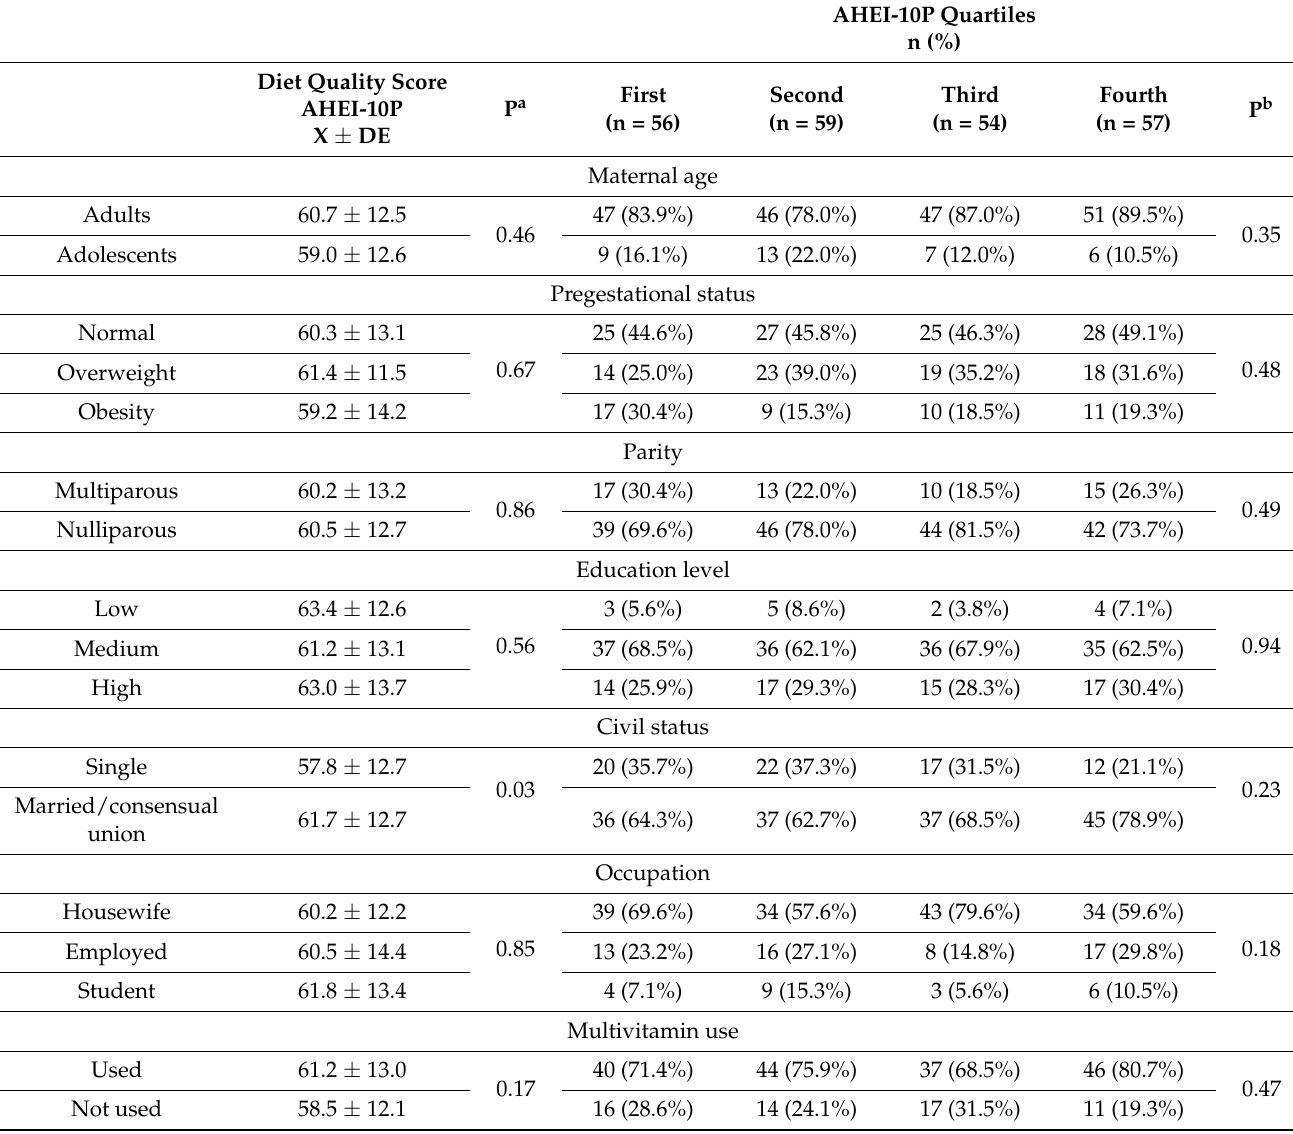
Table 2. Diet quality score, baseline characteristics, and maternal perinatal outcomes according to the AHEI-10P quartiles.